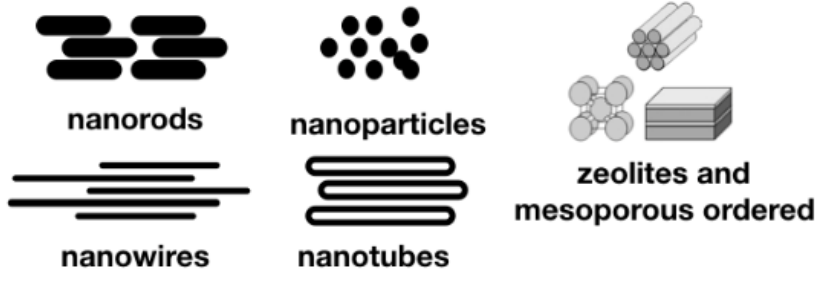
Figure 1. Scheme of the shape of the nanomaterials most useful for medicine.